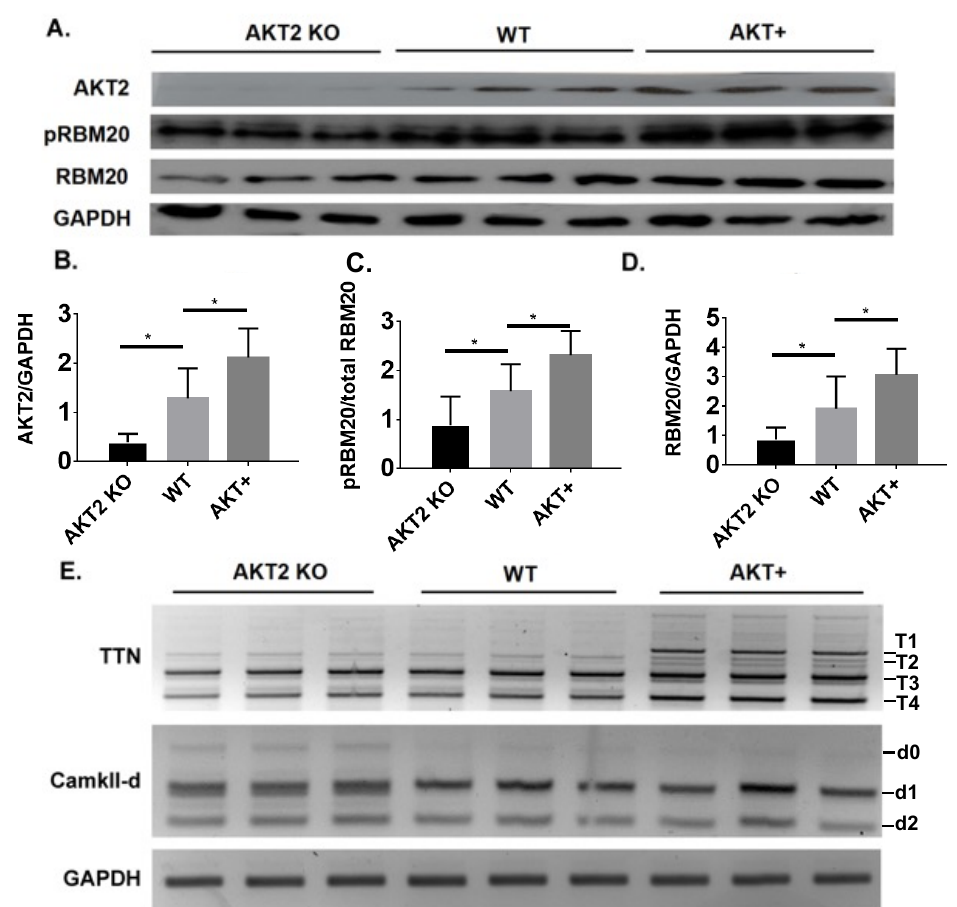
Figure 5. RBM20 phosphorylation and target splicing alterations in Akt2 KO and overexpressing